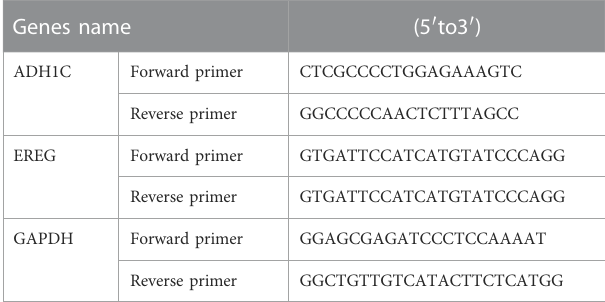
TABLE 1 Primers sequences corresponding to prognostic genes and